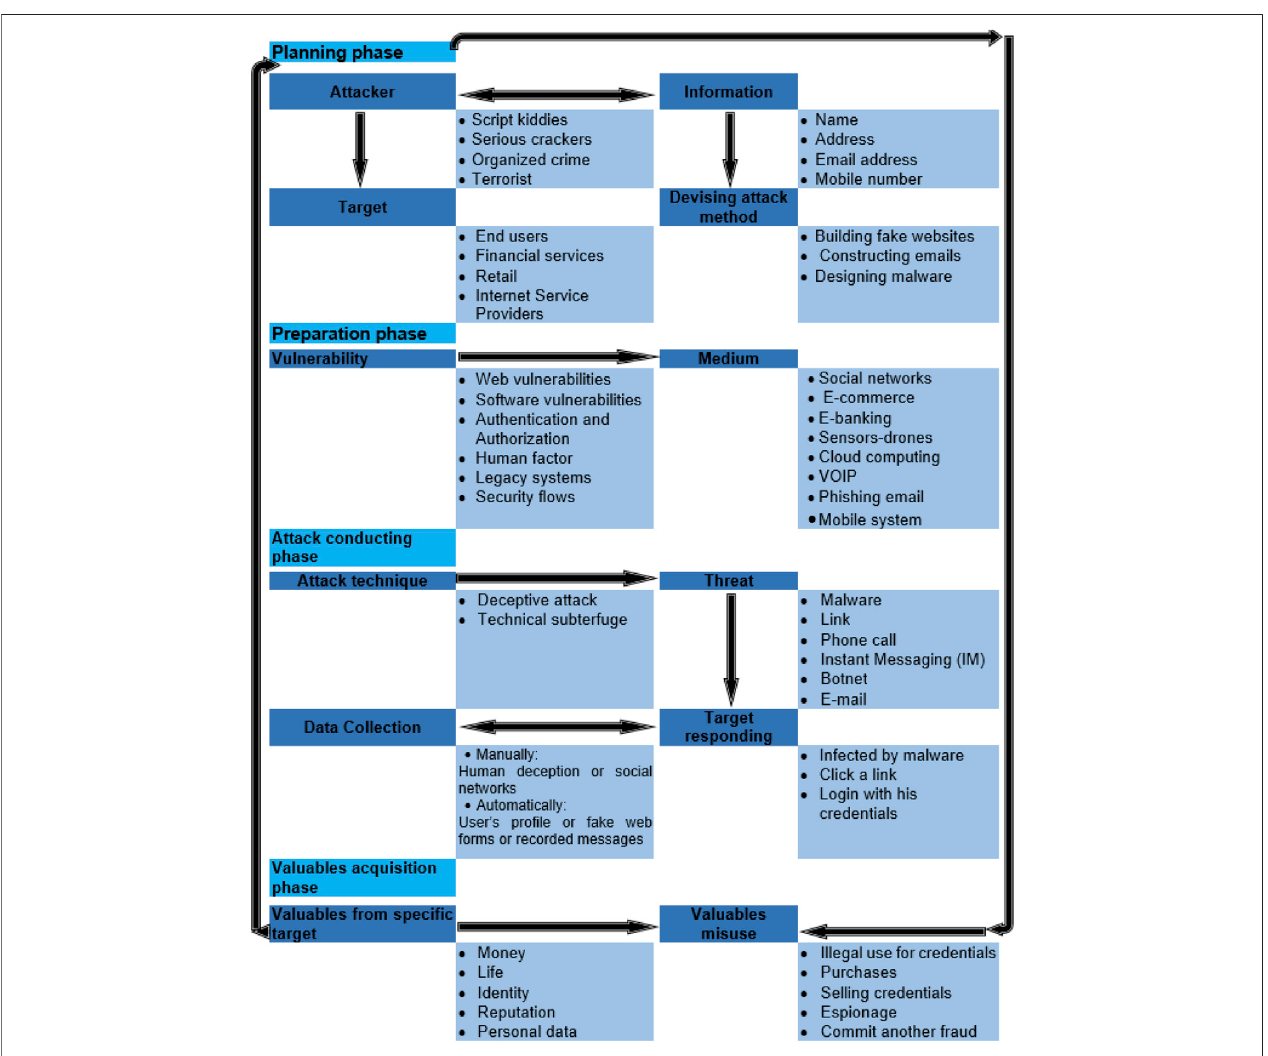
FIGURE 8 | The proposed anatomy of phishing was built upon the proposed phishing de fi nition in this article, which concluded from our understanding of a phishing attack.